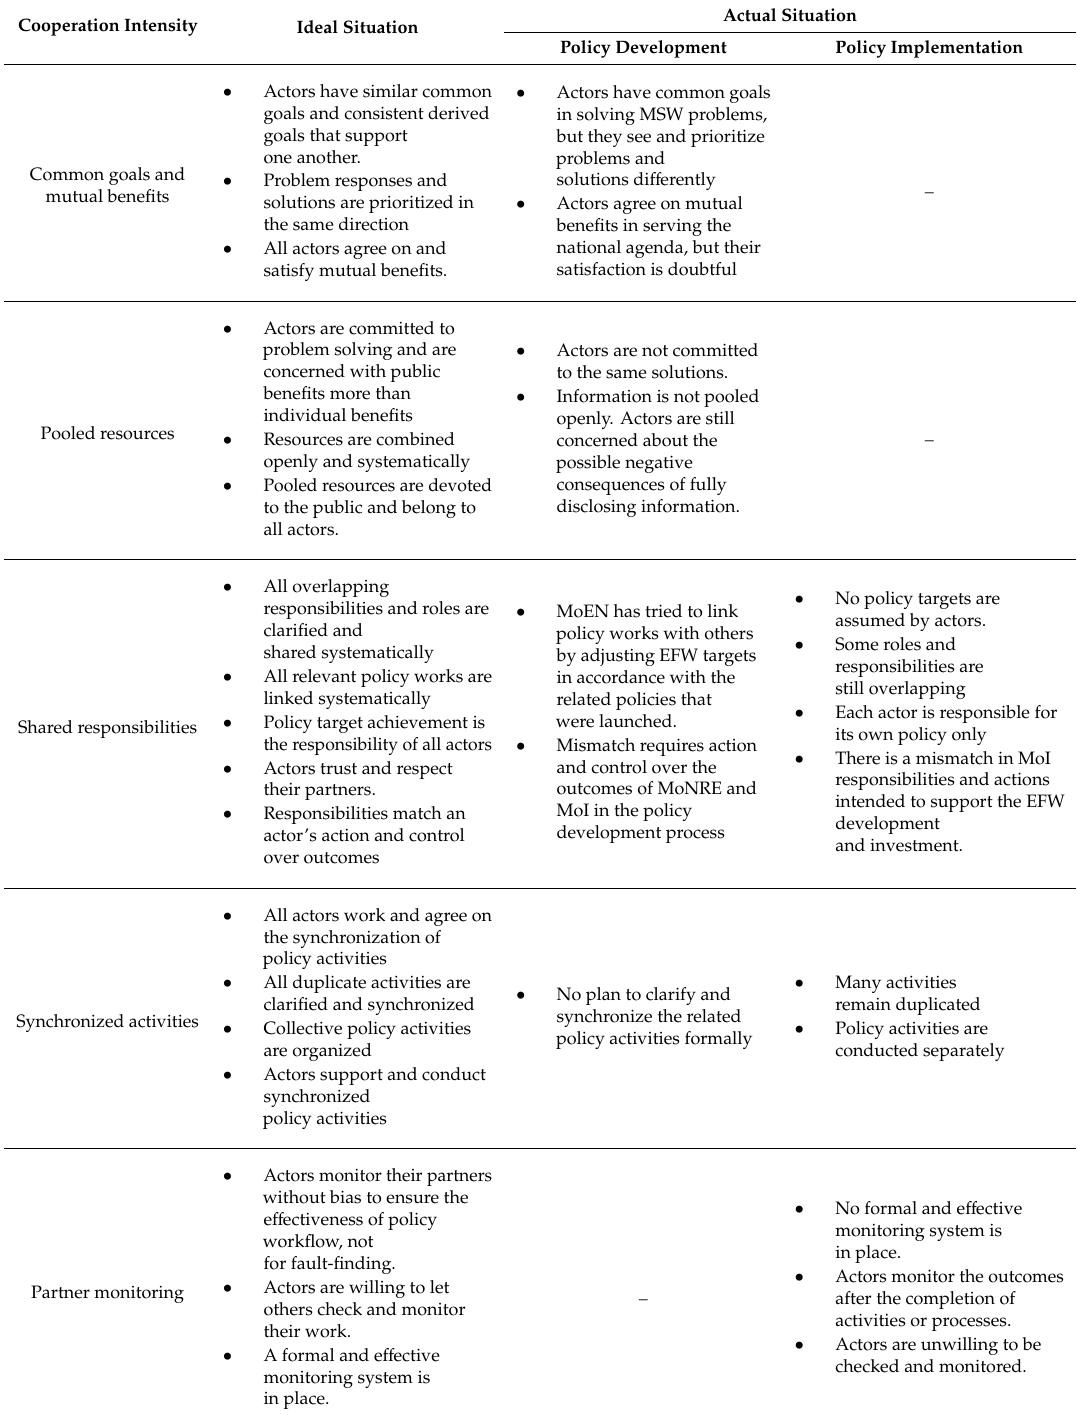
Table 9. Comparison of ideal and actual cooperate in the AEDP 2015 development and implementation. Cooperation